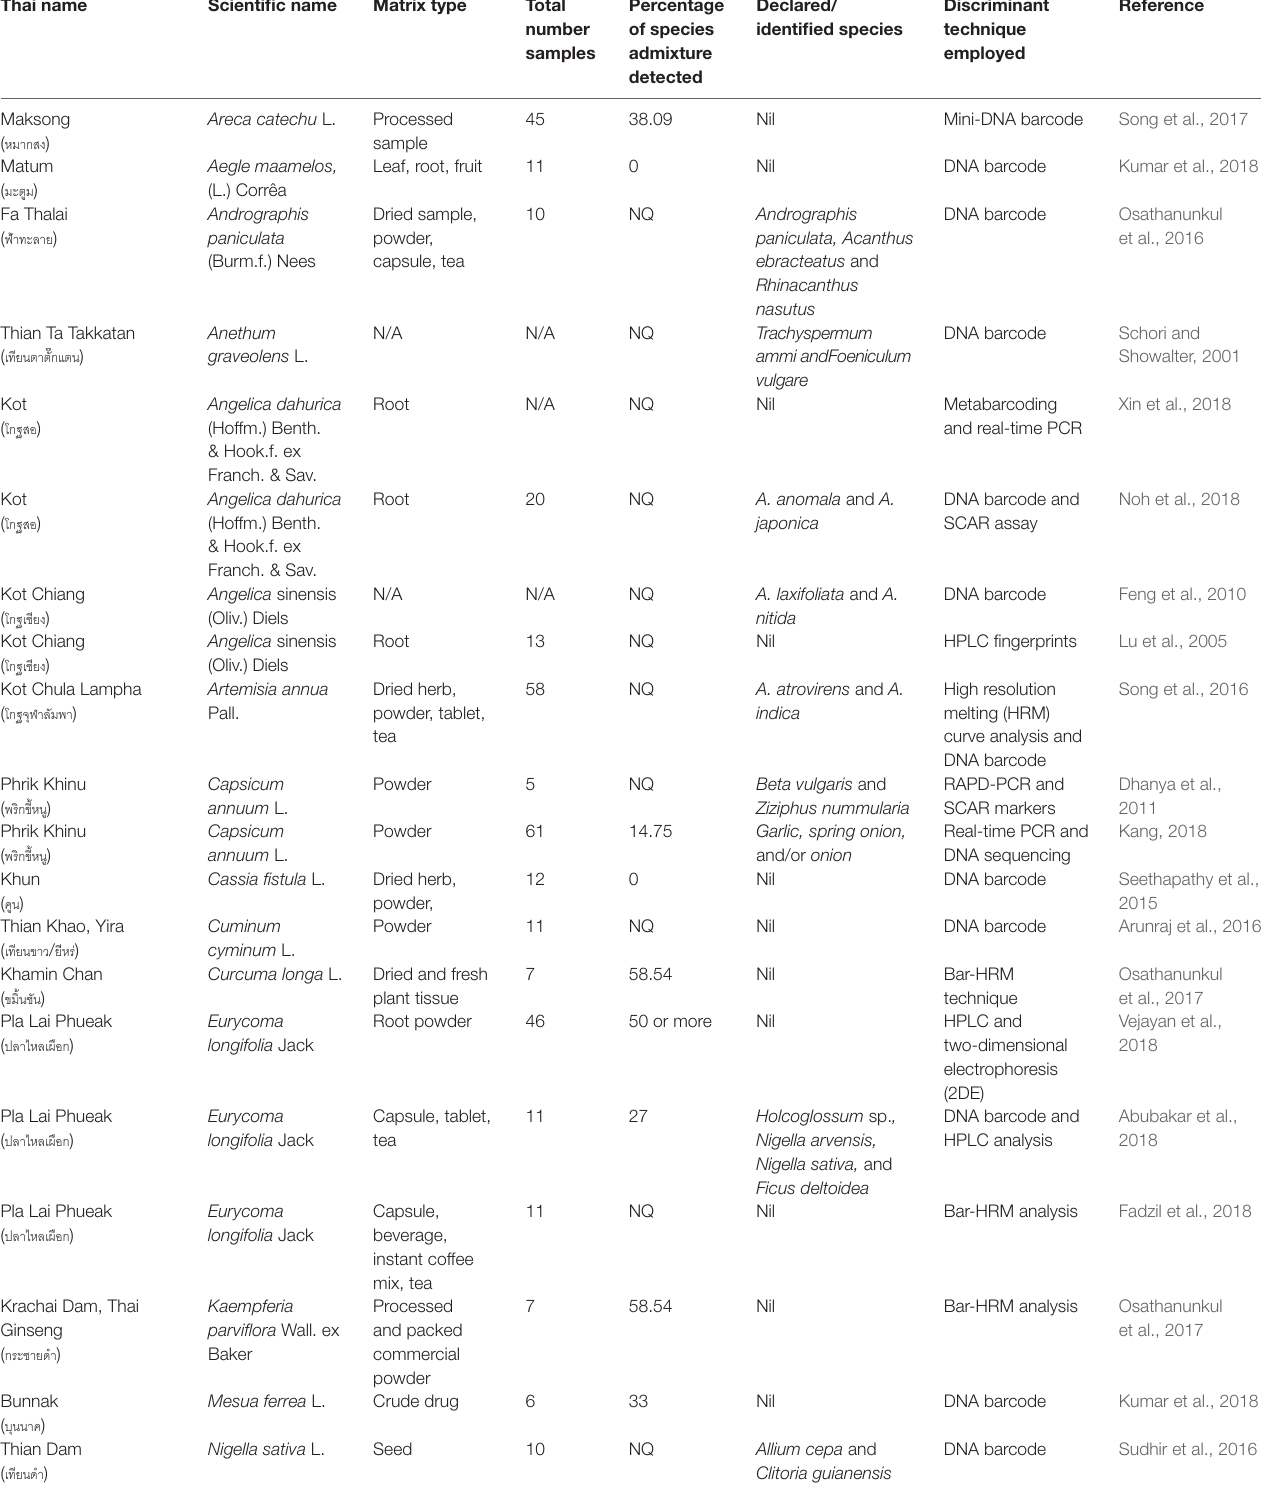
TABLe 2 | Species admixtures in the herbal trade samples of medicinal plants listed in the Thai Herbal Pharmacopoeia and techniques employed for